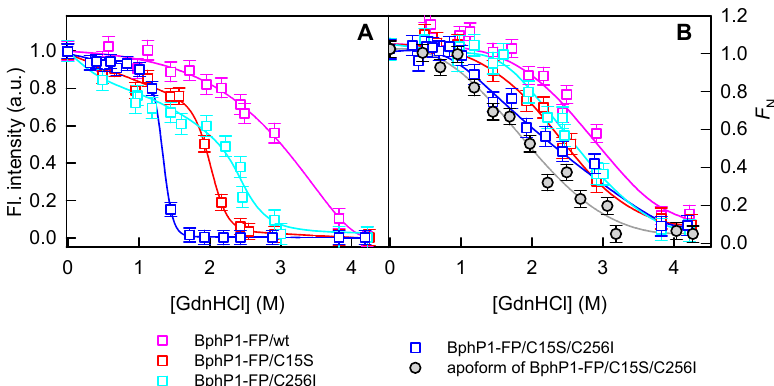
Figure 5. Stability of BphPl-FP and its variants in the holoform state against GdnHCl denaturation. ( A ) Changes in chromophore fluorescence intensity corrected to the total absorbance of the solution at the excitation wavelength, as described in “Materials and methods” section, are shown. Fluorescence was excited at 645 nm and recorded at 670 nm for BphPl-FP (pink squares) and BphPl-FP/C15S (red squares). Fluorescence was excited at 675 nm and recorded at 710 nm for BphPl-FP/C256I (cyan squares) and BphPl-FP/C15S/C256I (blue squares); ( B ) Dependences of the part of native molecules F N on the GdnHCl concentration calculated from ellipticity at 222 nm. Data